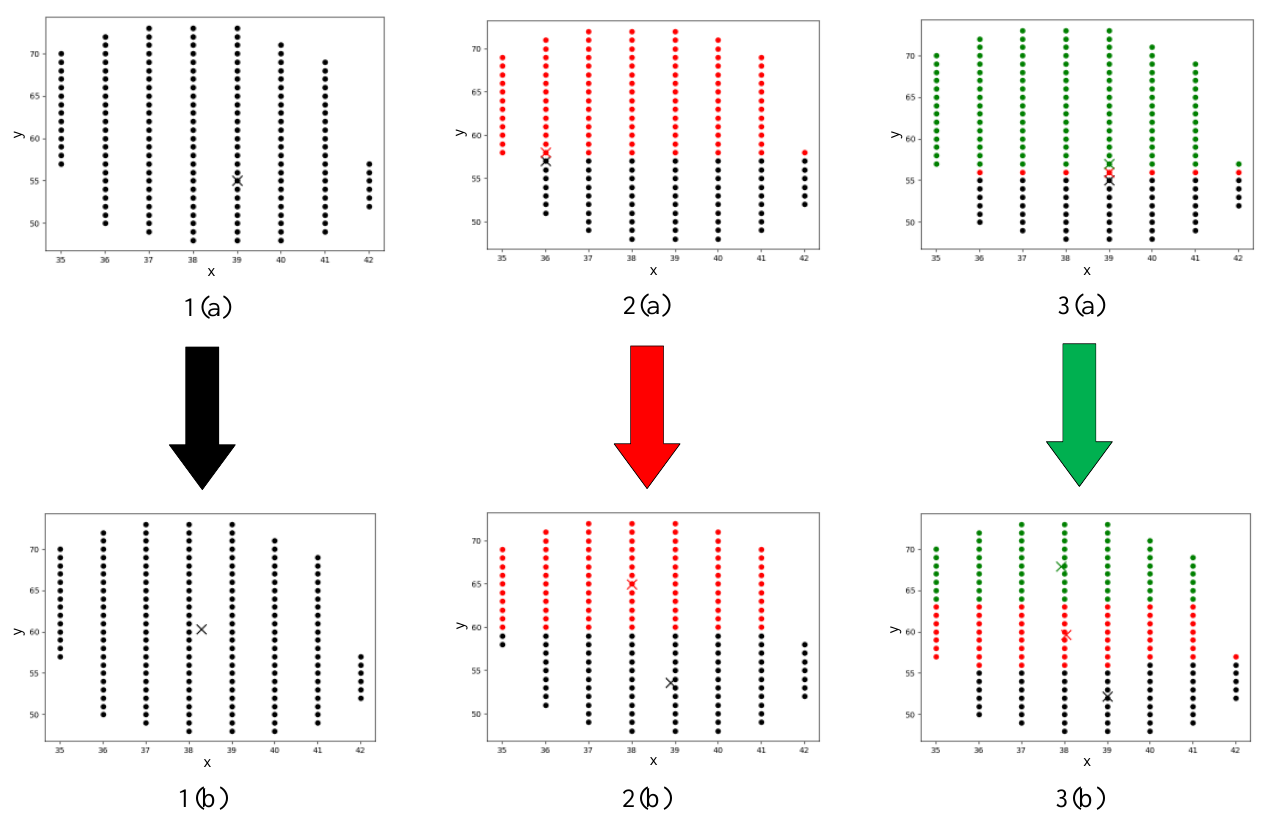
Figure 14. Evolutionary Graph of Clustering Iteration. The horizontal and vertical coordinates in the figure represent range grid coordinates and azimuth grid coordinates, respectively. ( 1a – 3a ) are processed predicated ConfMap of RODNet. We use the assumed number of targets as the input of clustering, randomly select the grid corresponding to the number of targets as the initial clustering center, and then cluster according to the principle of K-means. ( 1b – 3b ) are the clustering result graphs corresponding to the three assumed target numbers.